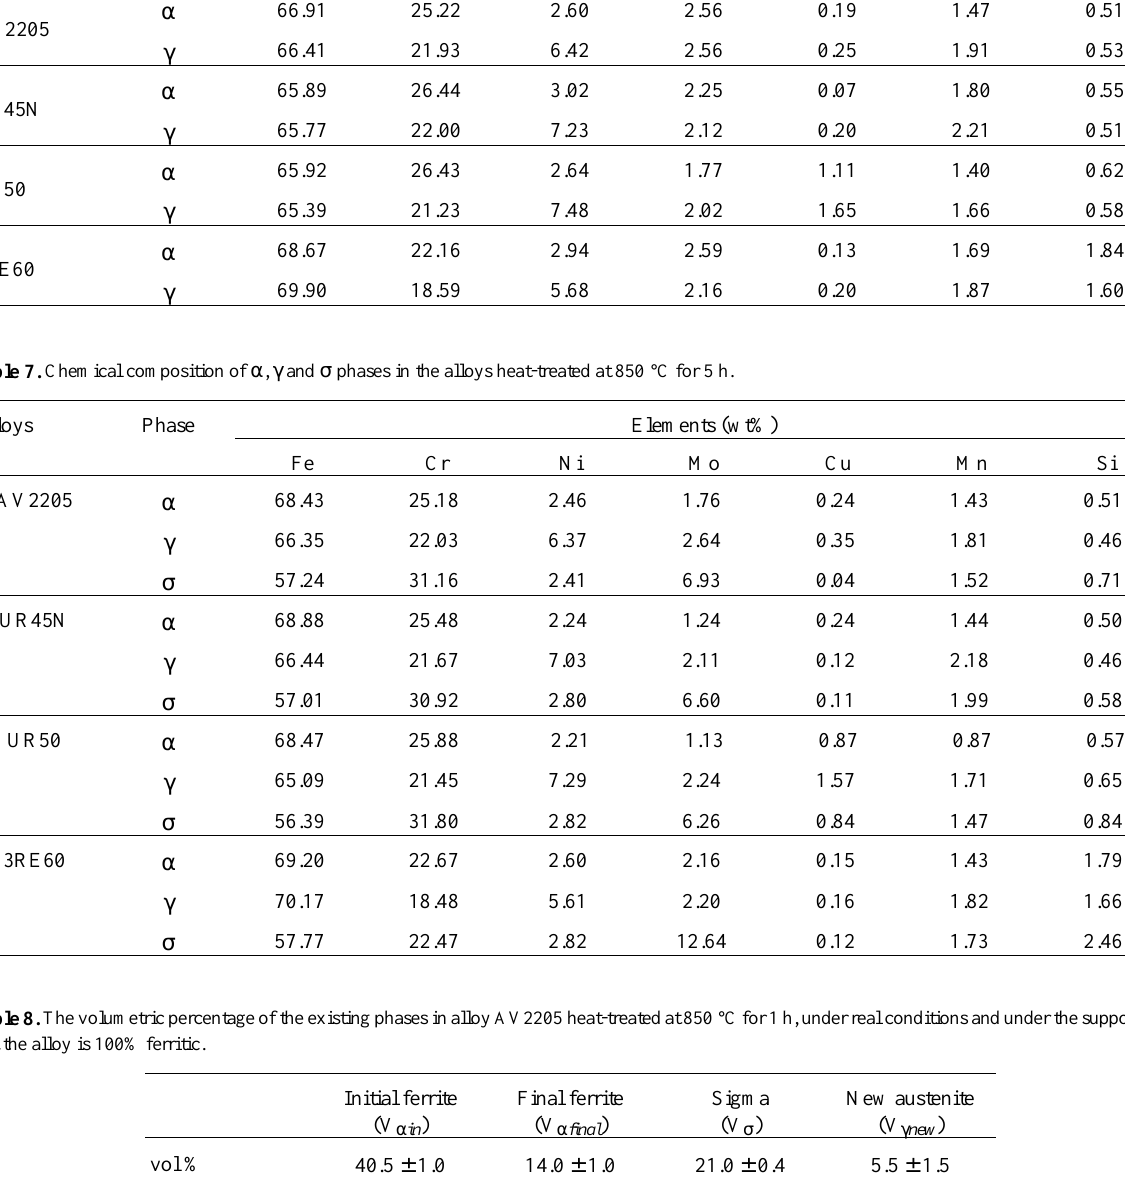
Table 6. Chemical composition of α and γ phases in the alloys heat-treated at 850 °C for 1 h. Alloys Phase Elements(wt%) Fe Cr